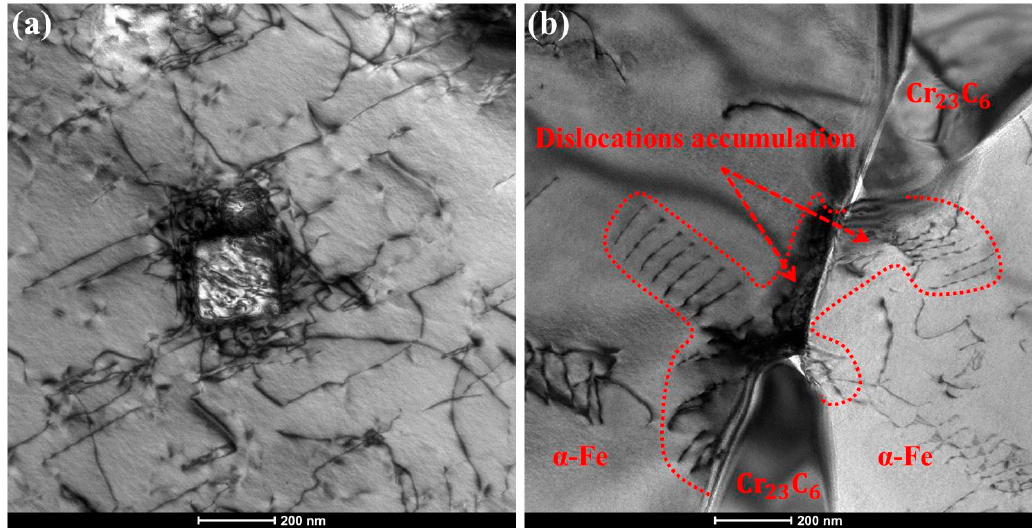
Figure 9. ( a ) Dislocations originate from the interior precipitate of α‐ Fe crystals; ( b ) The dislocations accumulation at the boundary of two α‐ Fe phases.